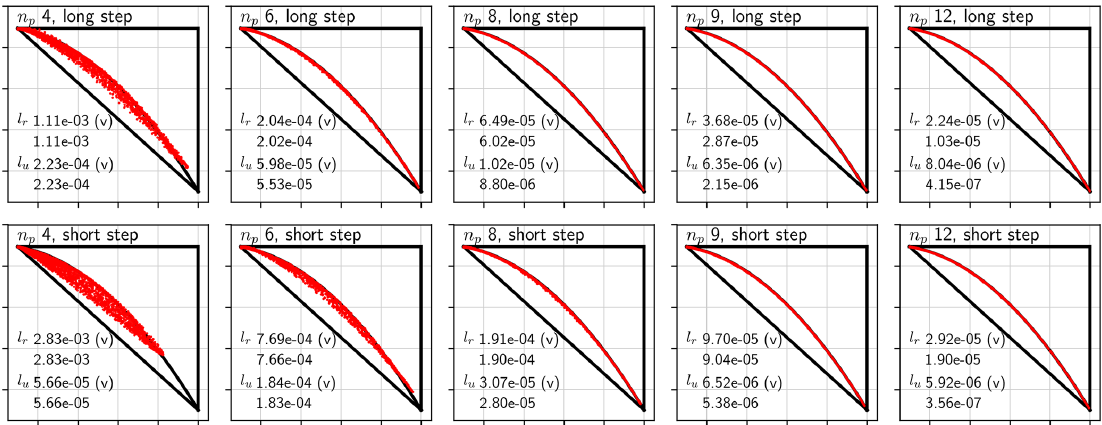
Figure 11. Mixing diagnostic following Sect. 3.5 of TS12. Compare with Figs. 11–14 in TR14. This figure shows results for dynamics-grid resolution of 1.5 ◦ . l o is exactly 0 in all cases because shape preservation is on, and so is not shown. See text for further